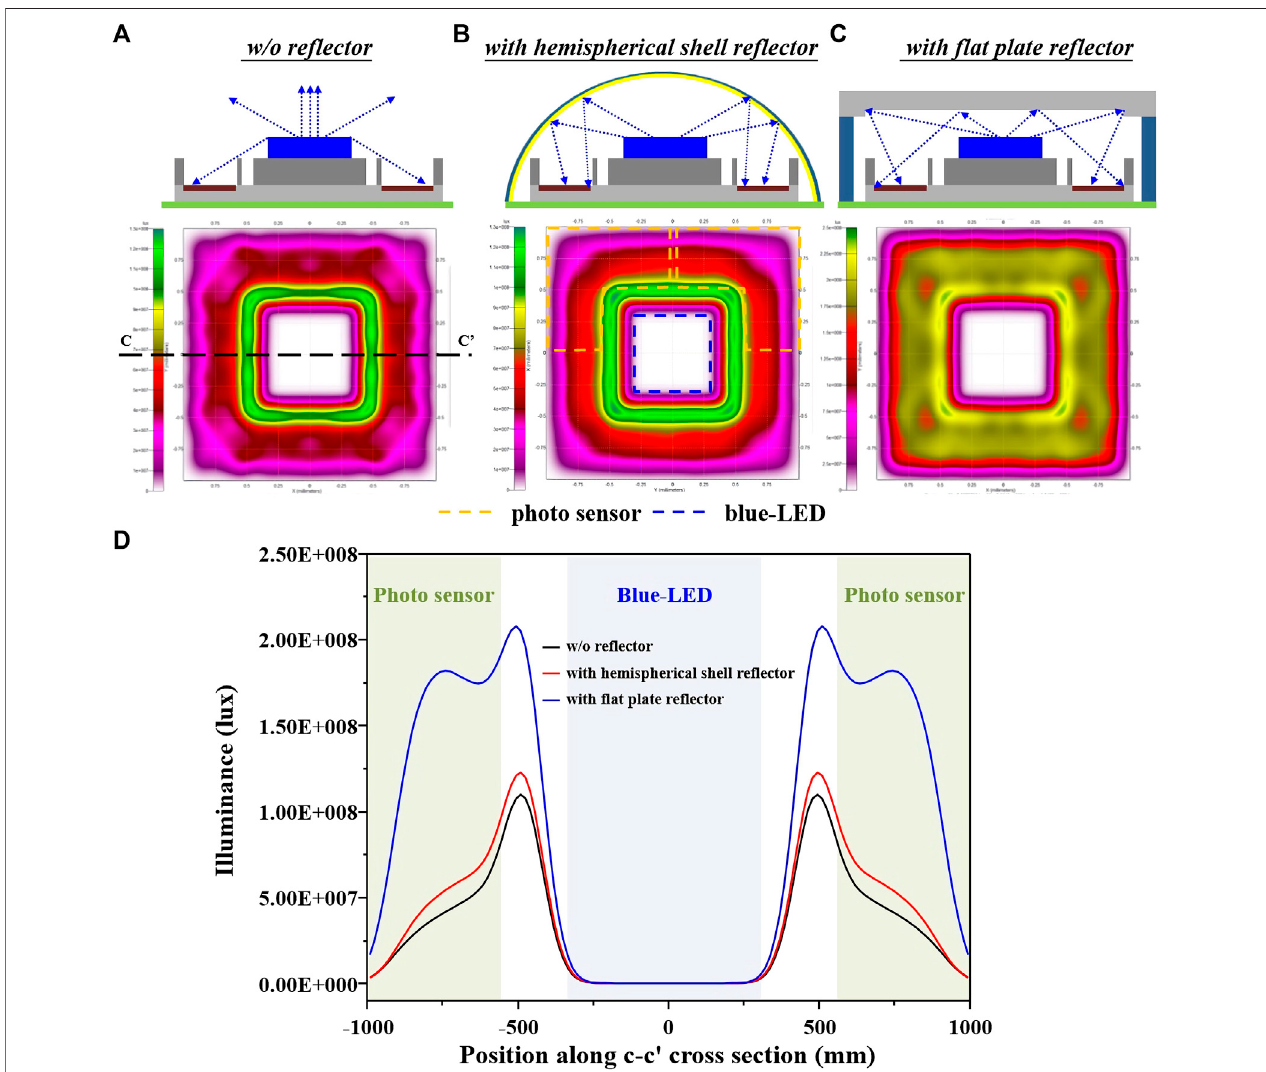
FIGURE 2 | Schematic of the light path emitted from the LED to the gas sensing chip and simulation results of the illuminance map for three different gas sensor designs, (A) forthegassensingchipwithoutre fl ector, (B,C) respectively,forgassensingchipswiththehemisphericalshellandthe fl atplatere fl ectors,and (D) simulation results of the light intensity